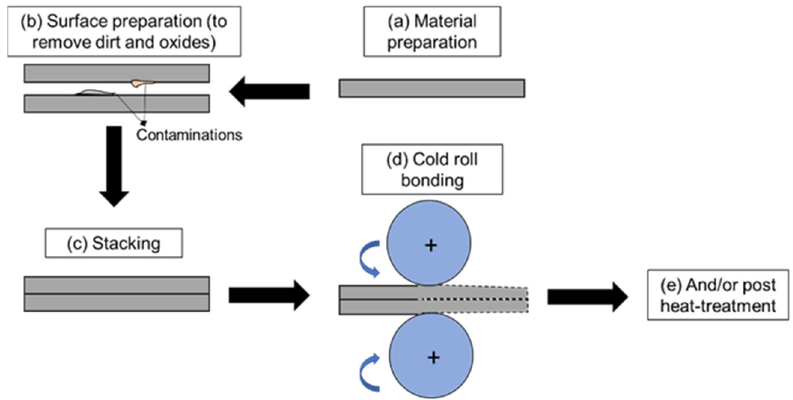
Figure 1. Steps involved in the CRB